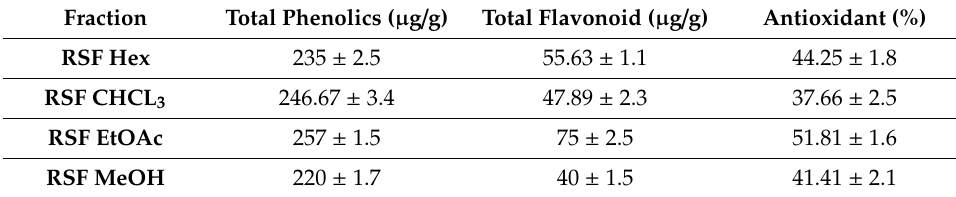
Table 2. Phenolic, flavonoid contents and radical scavenging activity of R. stricta fruit fractions.